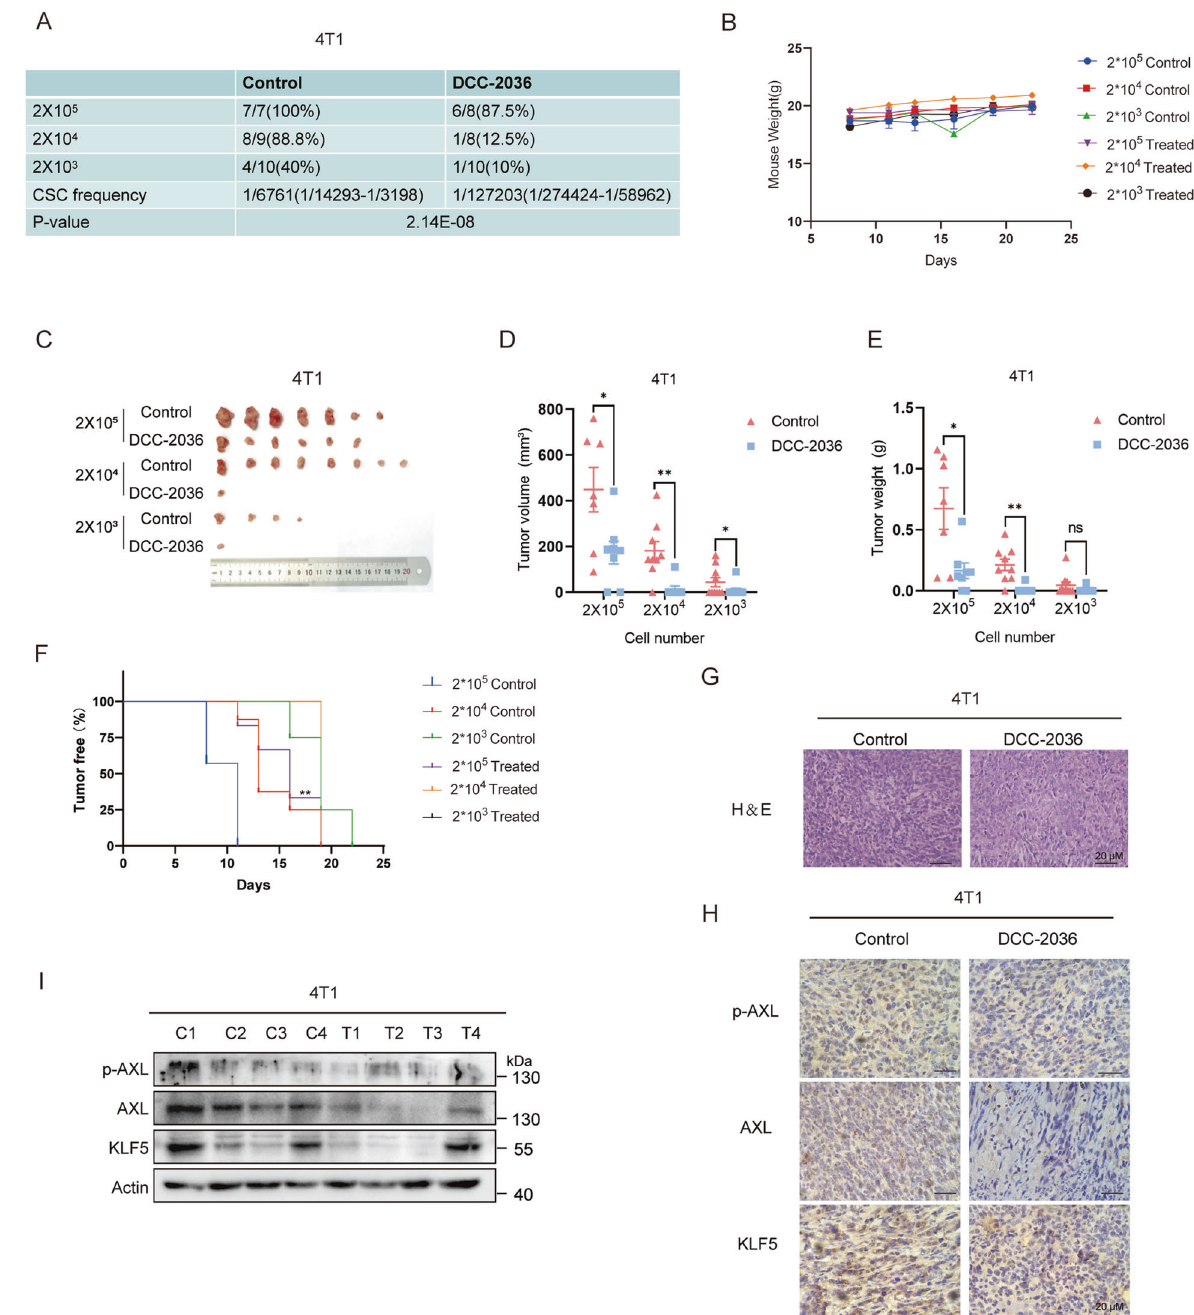
Fig. 7 DCC-2036 inhibits CSCs in vivo according to the limited dilution assay by pretreating 4T1 cells with DCC-2036 or DMSO for 48 h. A In vivo tumorigenicity assay with limited dilution using DMSO or DCC-2036 treated 4T1 cells respectively: 200,000 ( n = 7 and 8), 20,000 ( n = 9 and 8), or 2000 ( n = 10 and 10) cells per injection site. The frequency of BCSCs was calculated by ELDA. B Weight variation of mice following transplant of 4T1 cells into BALB/C mice after 7 days. C Images of tumor formation in BALB/C mice. D , E Transplanted tumors were harvested, and the tumor size and weight were measured at the end of the experiment. The statistical signi fi cance was determined by Student ’ s t -test. F Tumor-free survival curve of BALB/C mice is shown. G Hematoxylin and eosin (H&E) staining indicates the histology of tumor tissues. Scale bars, 20 μ m. H Immunohistochemical analysis using p-AXL, AXL, and KLF5 antibodies in xenograft tissues from BALB/C mice. Scale bars, 20 μ m. I Immunoblot of transplanted tumors from BALB/C mice posterior to the experiments. C means Control, T means DCC-2036. We chose the tumor tissues randomly for H&E staining, immunohistochemical analysis, and effect of DCC-2036 on TNBC stem cells. To further verify the The expression of p-AXL and AXL positively correlates with existence of this positive feedback loop, we detected the the expression of KLF5 in human TNBC specimens respectively correlation between the expression of AXL and KLF5 proteins. Since activation of AXL led to KLF5 stabilization, which in turn Immunohistochemical staining was conducted on 44 paraf fi n upregulated AXL at the transcriptional level, the positive feedback tissue samples of triple-negative breast cancer. Signi fi cantly regulation mechanism of AXL-KLF5 might mediate the inhibitory